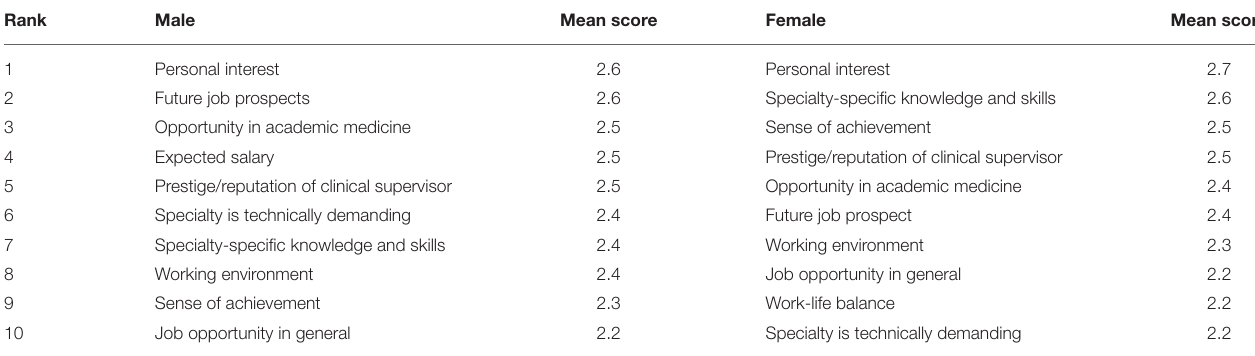
TABLE 2 | Top 10 influencing factors in specialty